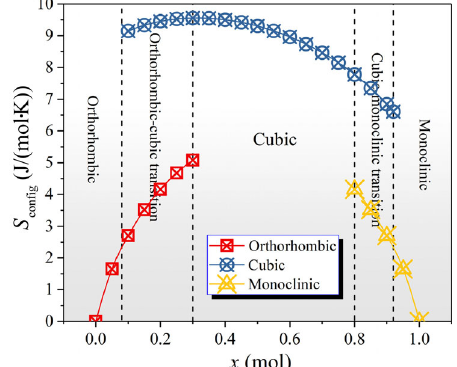
Fig. 14 Configurational entropy ( S config ) of the cation substitutions for the three different types of phases in the Li 3+ x Mg 2–2 x Nb 1– x Ti 2 x O 6 (0 ≤ x ≤ 1) system as a function of the substitution amount ( x ). Reproduced with permission from Ref. [247], © Acta Materialia Inc. 2021.